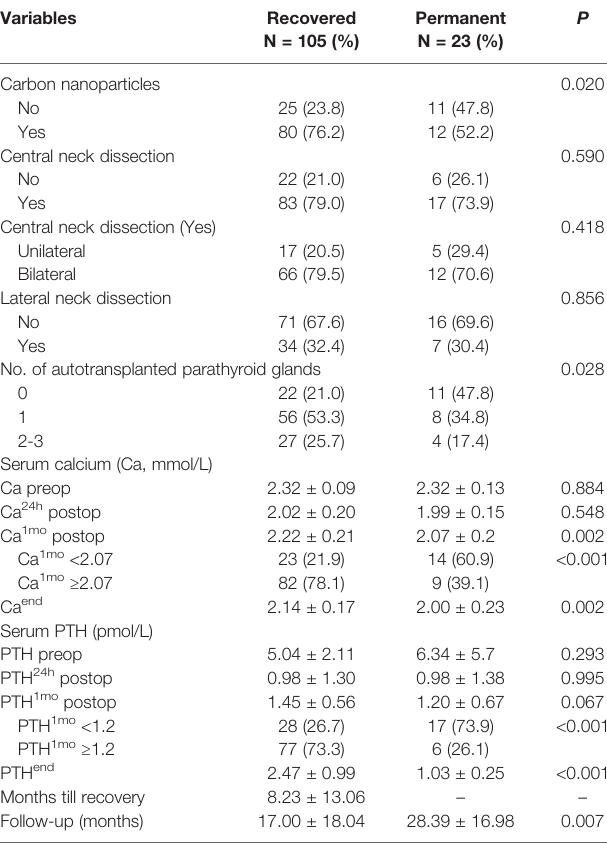
TABLE 2 | Surgical and laboratory variables of patients with protracted hypoparathyroidism who recovered the parathyroid function or developed permanent hypoparathyroidism.